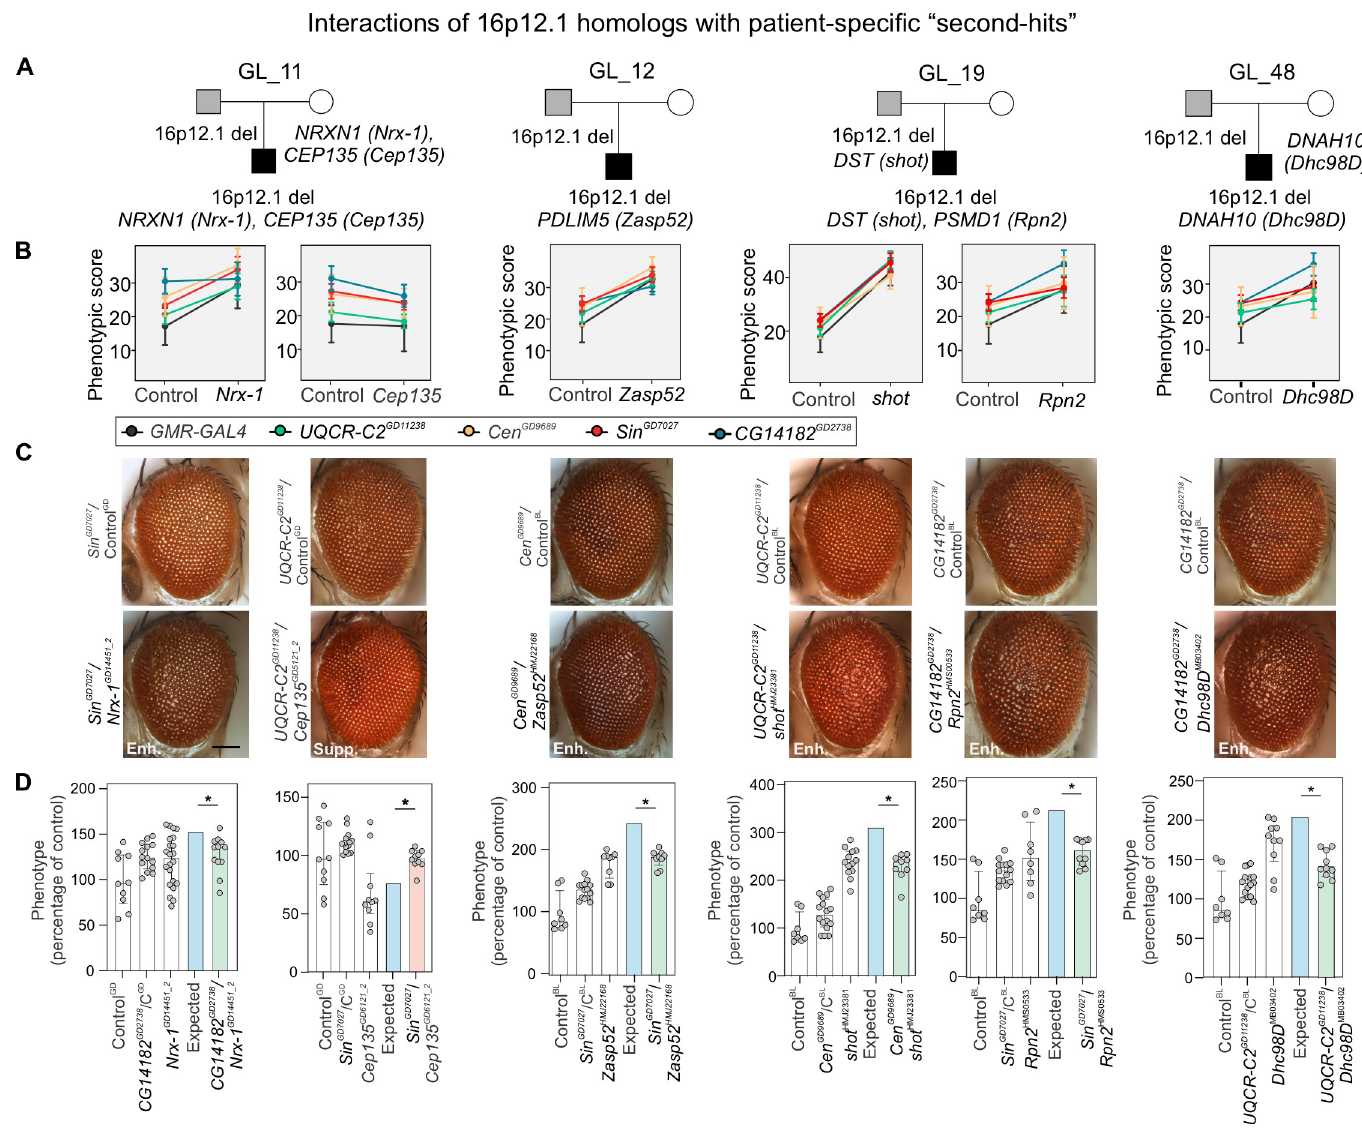
Fig 5. Homologs of patient-specific “second-hits” modulate phenotypes of 16p12.1 homologs. ( A ) Representative pedigrees of families with 16p12.1 deletion (affected child in black, carrier parent in grey) that were selected to study the effect of homologs (represented within parenthesis) of genes carrying “second-hits” towards phenotypes of homologs of 16p12.1 genes. ( B ) Observed phenotypic changes of 16p12.1 homologs by patient-specific “second-hit” homologs. Plots show the changes in Flynotyper scores (mean ± s.d.) for GMR-GAL4 control (grey) or recombinant lines of 16p12.1 homologs crossed with either background-specific control line (left) or with “second-hit” homologs (right). We note that represented changes in Flynotyper scores for Cen GD9689 / Nrx-1 GD14451_2 , UQCR-C2 GD11238 / Zasp52 HMJ22168 , and Sin GD7027 / Zasp52 HMJ22168 were not validated with multiple RNAi lines for the “second-hit” homolog. Flynotyper values for all the tested pairwise knockdowns are shown in S11–S14 Figs and validated enhancements and suppressions (using Mann-Whitney tests) are shown in S15 and S16 Figs . ( C ) Representative brightfield adult eye images for pairwise knockdowns that enhanced (Enh.) or suppressed (Supp.) phenotypes of 16p12.1 homologs are shown. Scale bar represents 100 μ m. ( D ) Examples of genetic interactions identified between the 16p12.1 homologs and homologs of patient-specific “second-hit” genes using the multiplicative model. Bar plots show normalized phenotypes (median ± interquartile range) for the 16p12.1 recombinant lines crossed with background-specific controls (Control GD or Control BL , also represented as C GD , C BL , respectively) or with RNAi lines for Nrx-1 GD14451_2 , Cep135 GD6121_2 , Zasp52 HMJ22168 , shot HMJ23381 , Rpn2 HMS0533 , Dhc98 DMB03402 . Sin GD7027 negatively interacted with Cep135 GD6121_2 and led to a more aggravating phenotype (two-tail one-sample Wilcoxon signed rank test with Benjamini-Hochberg correction, n = 10, � p = 0.012, in red) than expected (in blue) under a multiplicative model, while other examples of pairwise knockdowns with homologs “second-hit” genes shown here led to positive genetic interactions ( � p < 0.05, in green). Details of number of homologs, fly lines and crosses, as well as a list of full genotypes for all interaction experiments are provided in S1 File . Statistical details, including sample size, confidence intervals, and p-values, are provided in S6 File .